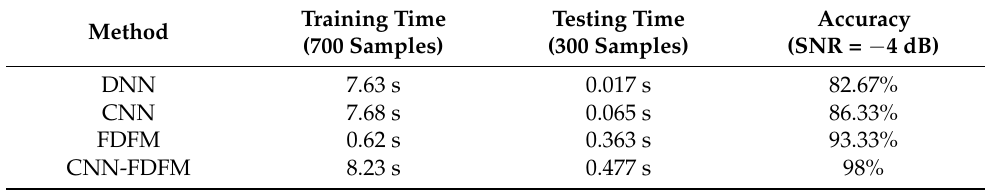
Table 7. The computation time of each method with 700 training samples and 300 test